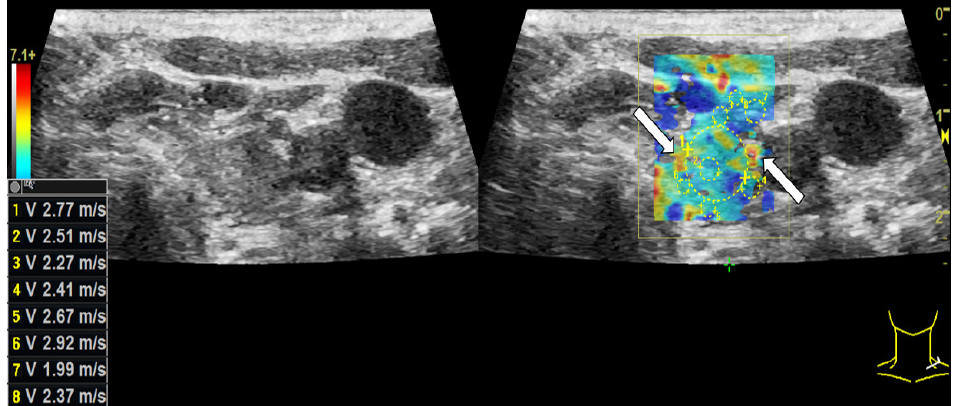
Figure 3. Shear-wave elastography [m/s] examination on a left thyroid lobe with thyroid adenoma. Only few hard areas (white arrows) can be detected in shear-wave elastography. The major part of the nodule appears rather soft. Neither the stiffness values of the lesion nor of the normal thyroid tissue surpass the calculated cut-off value of 4.04 marginally and 3.88 centrally.